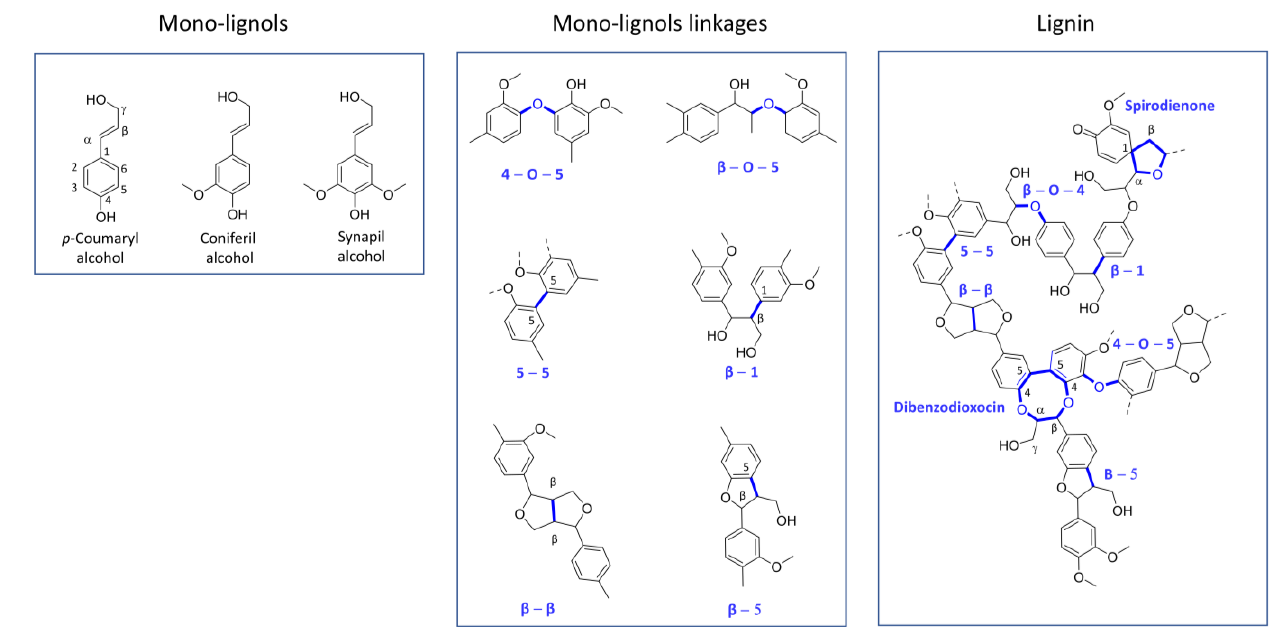
Figure 2. The chemical structure of the three mono-lignols. The radical–radical coupling between mono-lignols results in a variety of possible C-C and C-O ether linkages creating a complex network. The particular lignin composition in terms of mono-lignols, type of linkages, and condensed struc- tures, such as dibenzodioxocin (5-5/β-O-4/α-O-4) and spirodienone (β-1/α-O-α), can vary from spe- cies to species and can change during the course of the plant’s growth. Baucher, Boerjan, and Ralph published comprehensive review papers in the field of lignin structure [27,30,34,35].